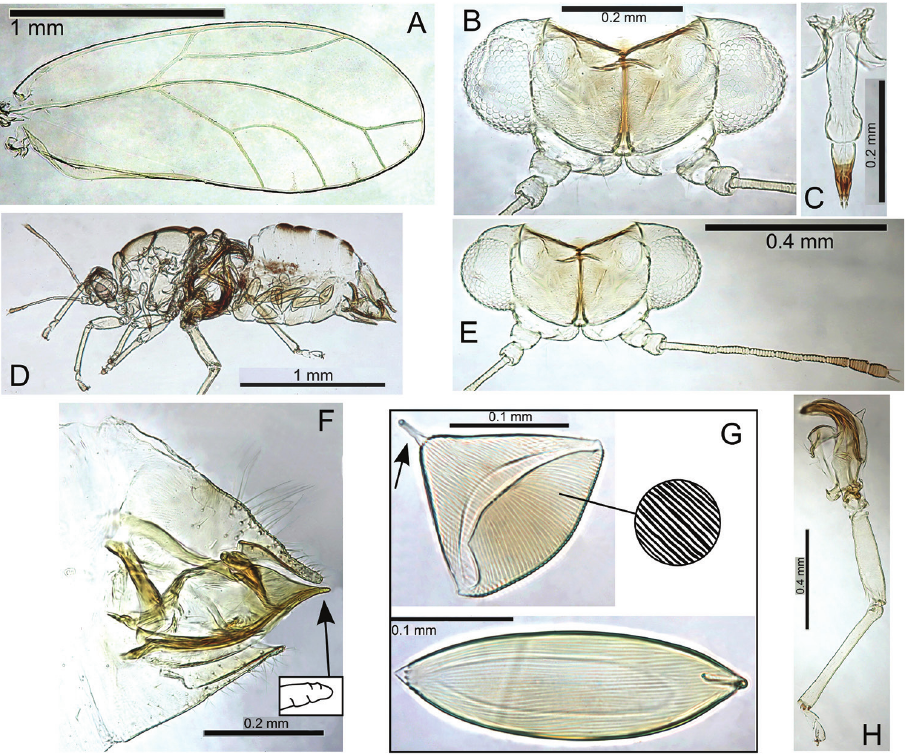
Figure 9. Pariaconus nigrilineatus sp. n. (female) A fore wing B head C proboscis D habitus E head and antenna F terminalia (ovipositor serrations indicated) G eggs (tail and striations indicated) H hind